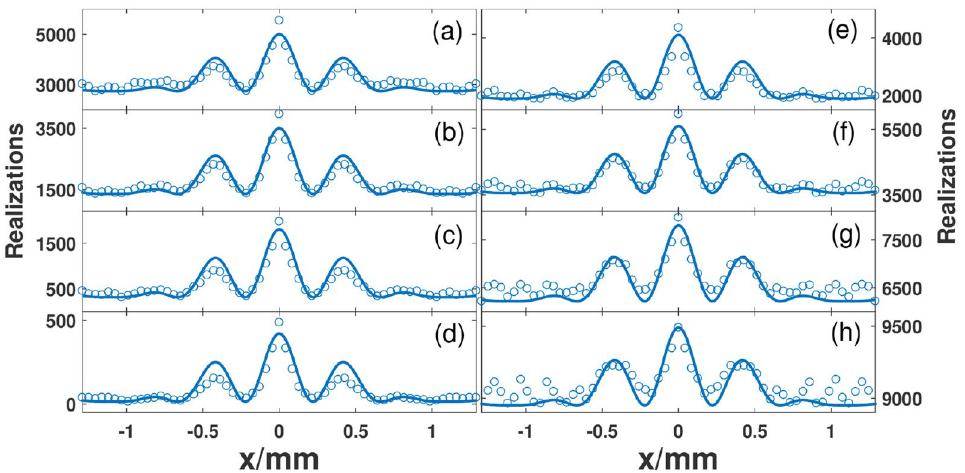
Figure 6. Experimental results with different thresholds. Left column and right column show the results for the cases of intensities at symmetric positions greater and smaller than thresholds, respectively. From top to bottom, the thresholds are set to 20, 34, 60 and 100, respectively. The visibilities are 0.34, 0.49, 0.72 and 0.94 for ( a )–( d ), respectively. The visibilities are 0.39, 0.25, 0.12 and 0.033 for ( e )–( h ),